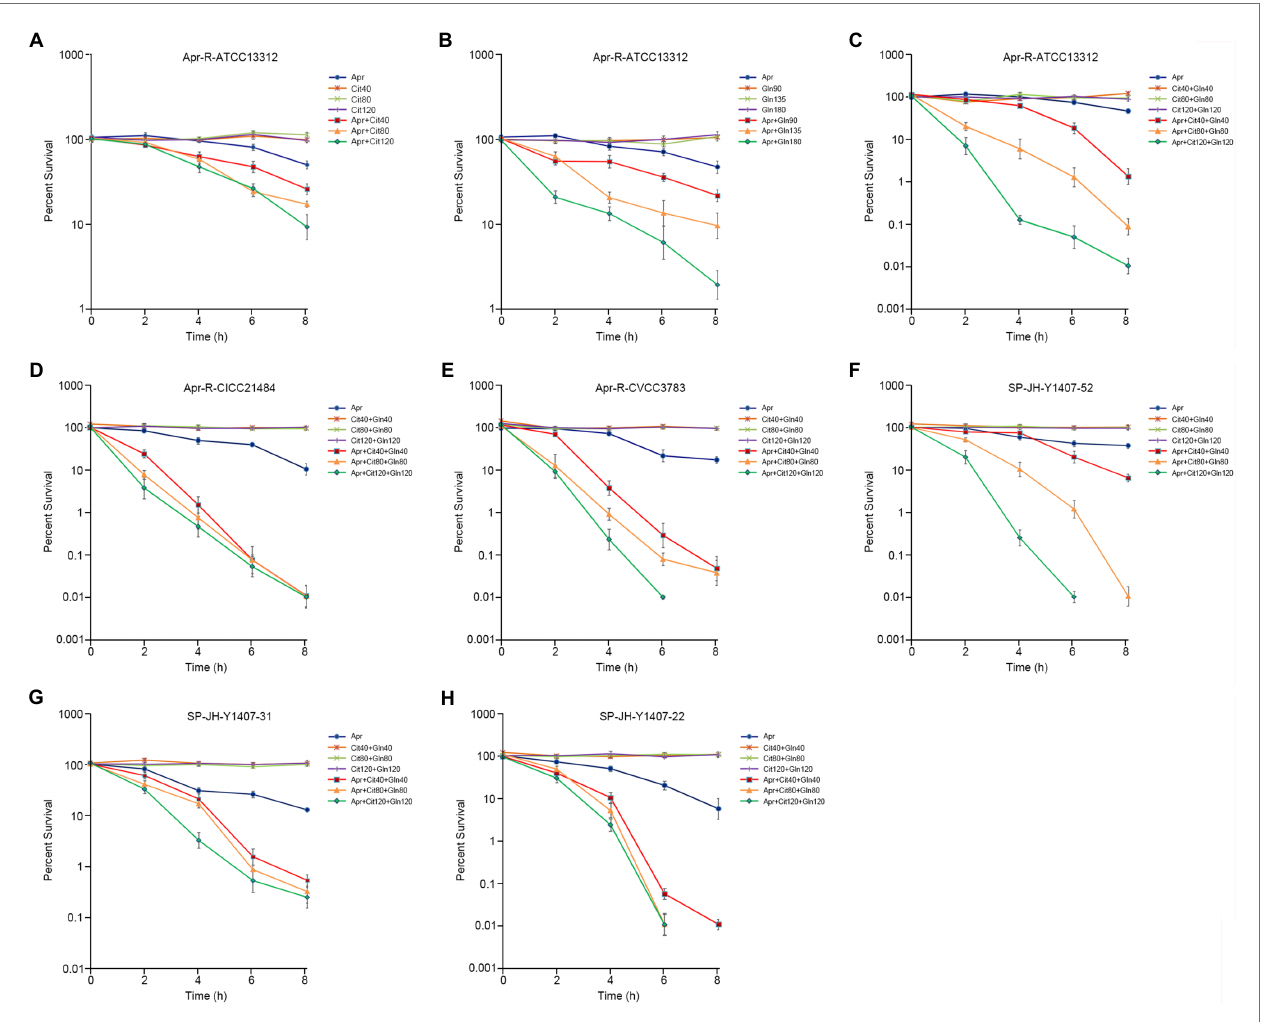
FIGURE 2 | Effect of exogenous citrulline and glutamine on induced and clinical isolates of Apramycin-resistant Salmonella. (A) Effect of different doses of citrulline on Apramycin-induced resistant Salmonella ATCC13312. (B) Effect of different doses of glutamine on Apramycin-induced resistant Salmonella ATCC13312. (C) Effect of citrulline and glutamine on Apramycin-induced resistant Salmonella ATCC13312. (D) Effect of citrulline and glutamine on Apramycin-induced resistant Salmonella CICC21484. (E) Effect of citrulline and glutamine on Apramycin-induced resistant Salmonella CVCC3783. (F) Effect of citrulline and glutamine on clinical isolated drug-resistant Salmonella SP-JH-Y1407-52. (G) Effect of citrulline and glutamine on clinical isolated drug-resistant Salmonella SP-JH-Y1407-31. (H) Effect of citrulline and glutamine on clinical isolated drug-resistant Salmonella SP-JH-Y1407-22. “Apr” represents Apramycin; “Cit40, Cit80, and Cit120” represent citrulline at a concentration of 40 mm, 80 mm, and 120 mm, respectively; and “Gln90, Gln135, Gln180, Gln40, Gln80, and Gln120” represent glutamine at a concentration of 90 mm, 135 mm, 180 mm, 40 mm, 80 mm, and 120 mm,